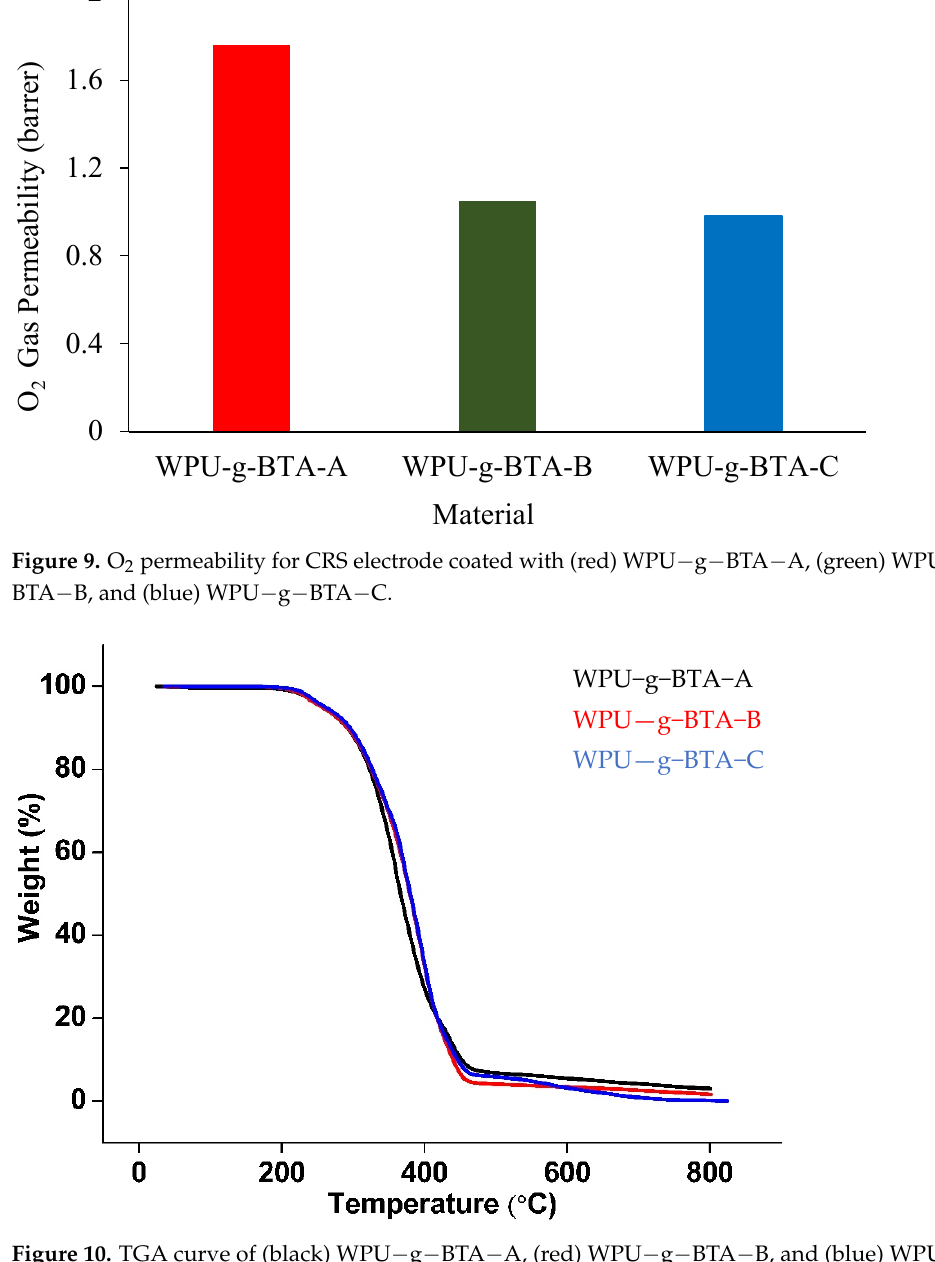
Figure 9. O 2 permeability for CRS electrode coated with (red) WPU − g − BTA − A, (green) WPU − g − BTA − B, and (blue) WPU − g − BTA − C.